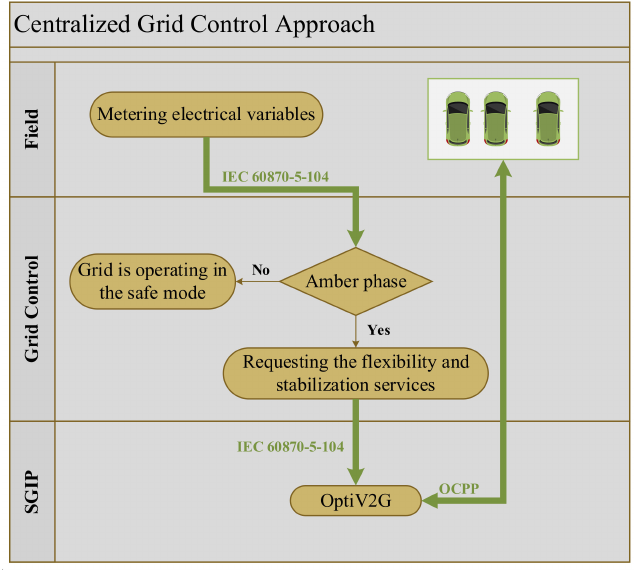
Figure 2. Centralized grid control